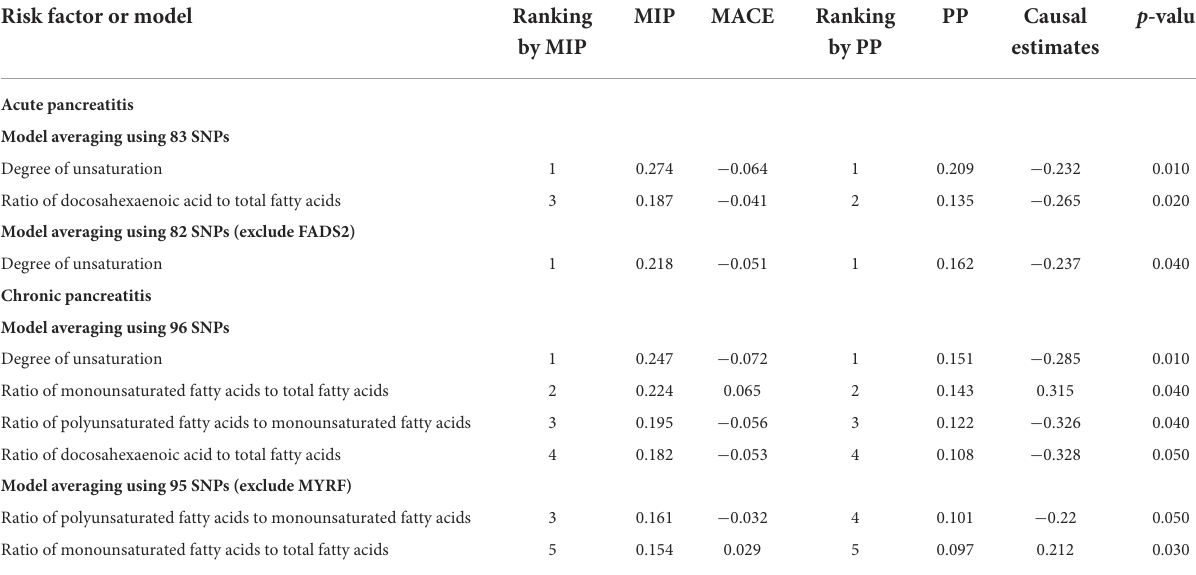
TABLE 2 Ranking of traits indicative of the level of fatty acid saturation for acute pancreatitis and chronic pancreatitis using MR-BMA. Risk factor or model Ranking